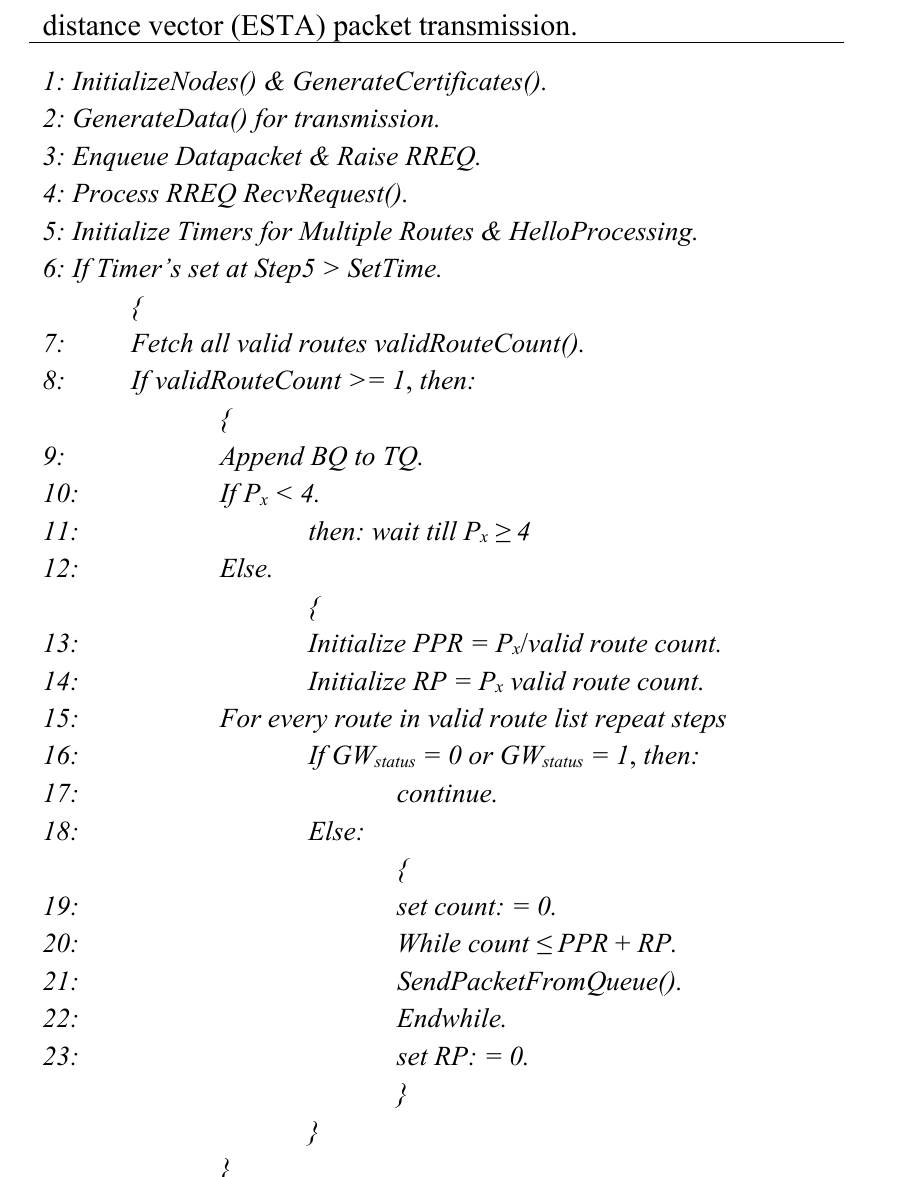
Algorithm 1. Enhanced Secure Trusted Ad Hoc